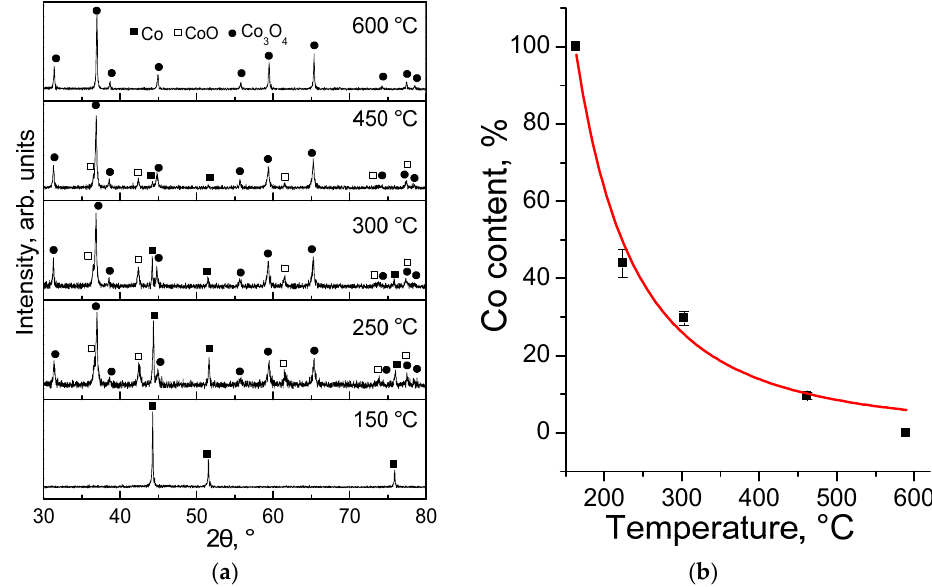
Figure 3. X ‐ ray pattern of cobalt nanoparticles after heating at different temperatures in the air atmosphere ( a ) and change in the Co content in the samples depending on the calcination temperature ( b ). The morphology of Co particles undergoes significant changes after heating to 250 °C (Figure 4). Voids, which are typical for metals oxidised by air oxygen during heating, are formed in the particles at the metal/oxide interface—the so ‐ called Kirkendall effect [36–38]. An increase in the heating temperature leads to the gradual removal of the metal from cavities in the formed particles and the sintering of particle fragments with the formation of ~100 nm crystallites (Figure 4). The formation of hollow cobalt particles is considered in detail in [38]. The formation of such morphology is caused by thermally activated diffusion of cobalt cations through the oxide layer, followed by oxidation. ( a ) ( b ) ( c ) ( d ) Figure 4. TEM images of the nanoparticles obtained after heating Co nanoparticles up to 250 ° С ( a ), 300 ° С ( b ), 450 ° С ( c ), and 600 ° С ( d ).